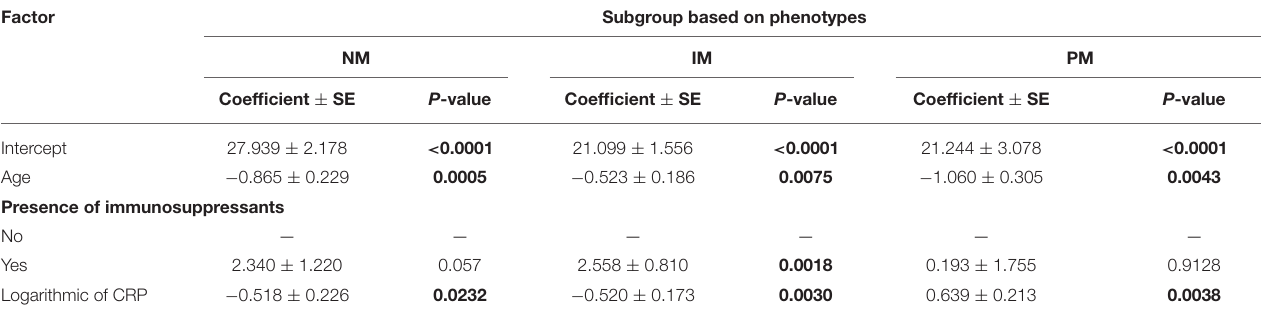
TABLE 4.2 | Effects of CRP concentration on voriconazole dose required to achieve therapeutic range (mg/kg) on three subgroups of patients based on phenotypes. Factor